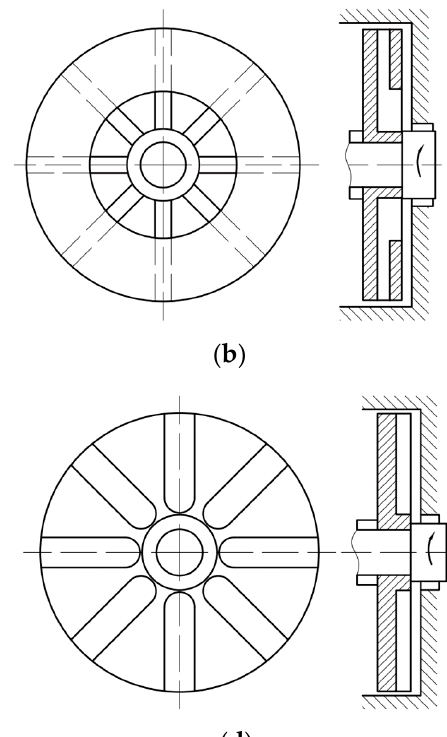
Figure 1. Common structures of the centrifugal sealing impellers: ( a ) open impeller with blades; ( b ) semi-open impeller with blades; ( c ) closed impeller with blades; and ( d ) open impeller with flow channel (groove).